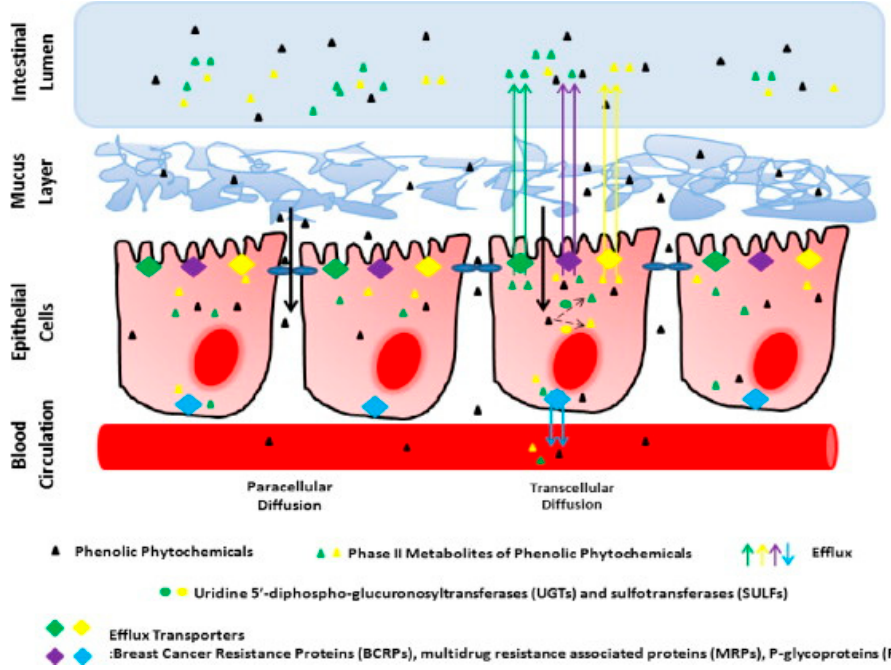
Figure 2. Process of passive diffusion of phenolic phytochemicals into epithelial cells followed by metabolism and active efflux. Adapted with permission from [49] 2022, Zheng et al.